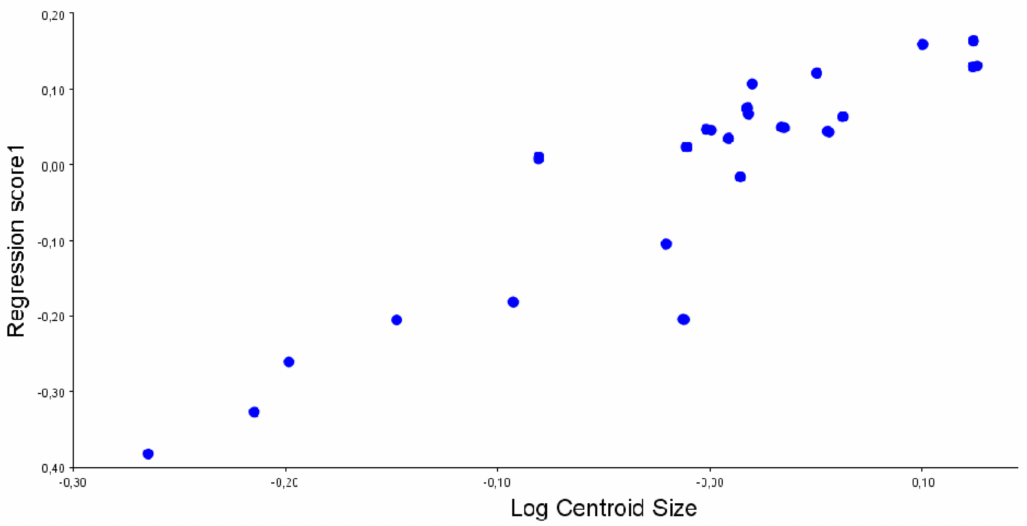
Figure 2. Regression of size (expressed as log of centroid size) versus shape. The analysis demonstrates significant allometry, with 70.8% of the shape variation explained by size. Dimensionless